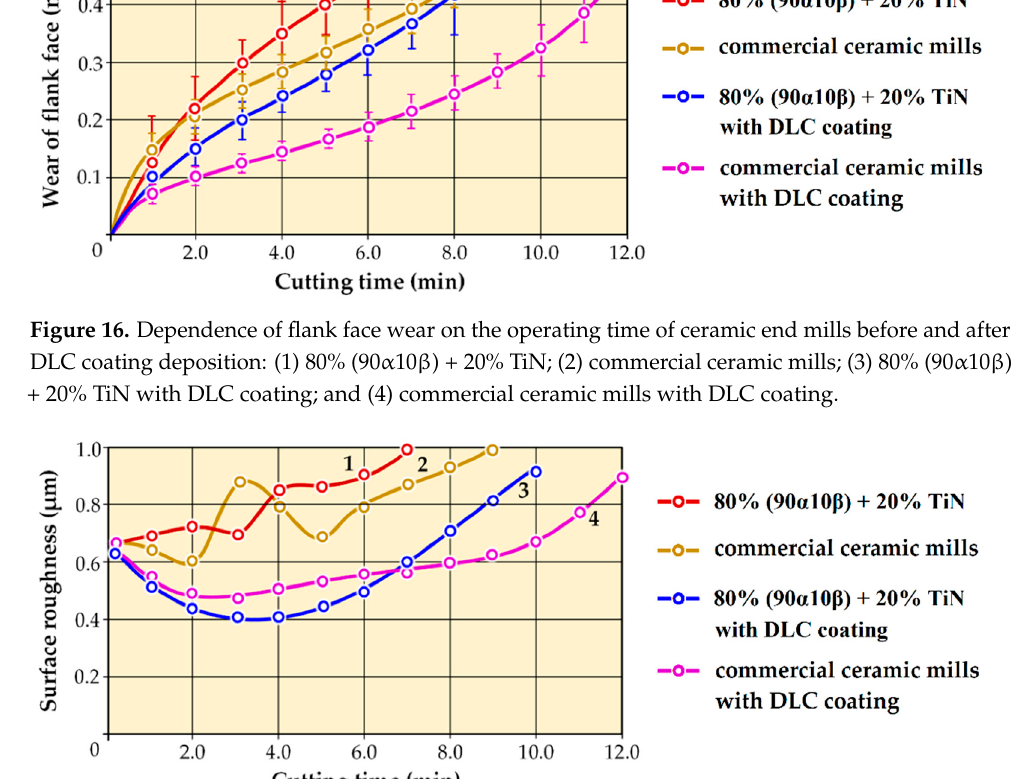
Figure 17. Dependence of the processed surface roughness on the operating time of ceramic end mills before and after DLC coating deposition: (1) 80% (90 α 10 β ) + 20% TiN; (2) commercial ceramic mills; (3) 80% (90 α 10 β ) + 20% TiN with DLC coating; and (4) commercial ceramic mills with DLC coating.